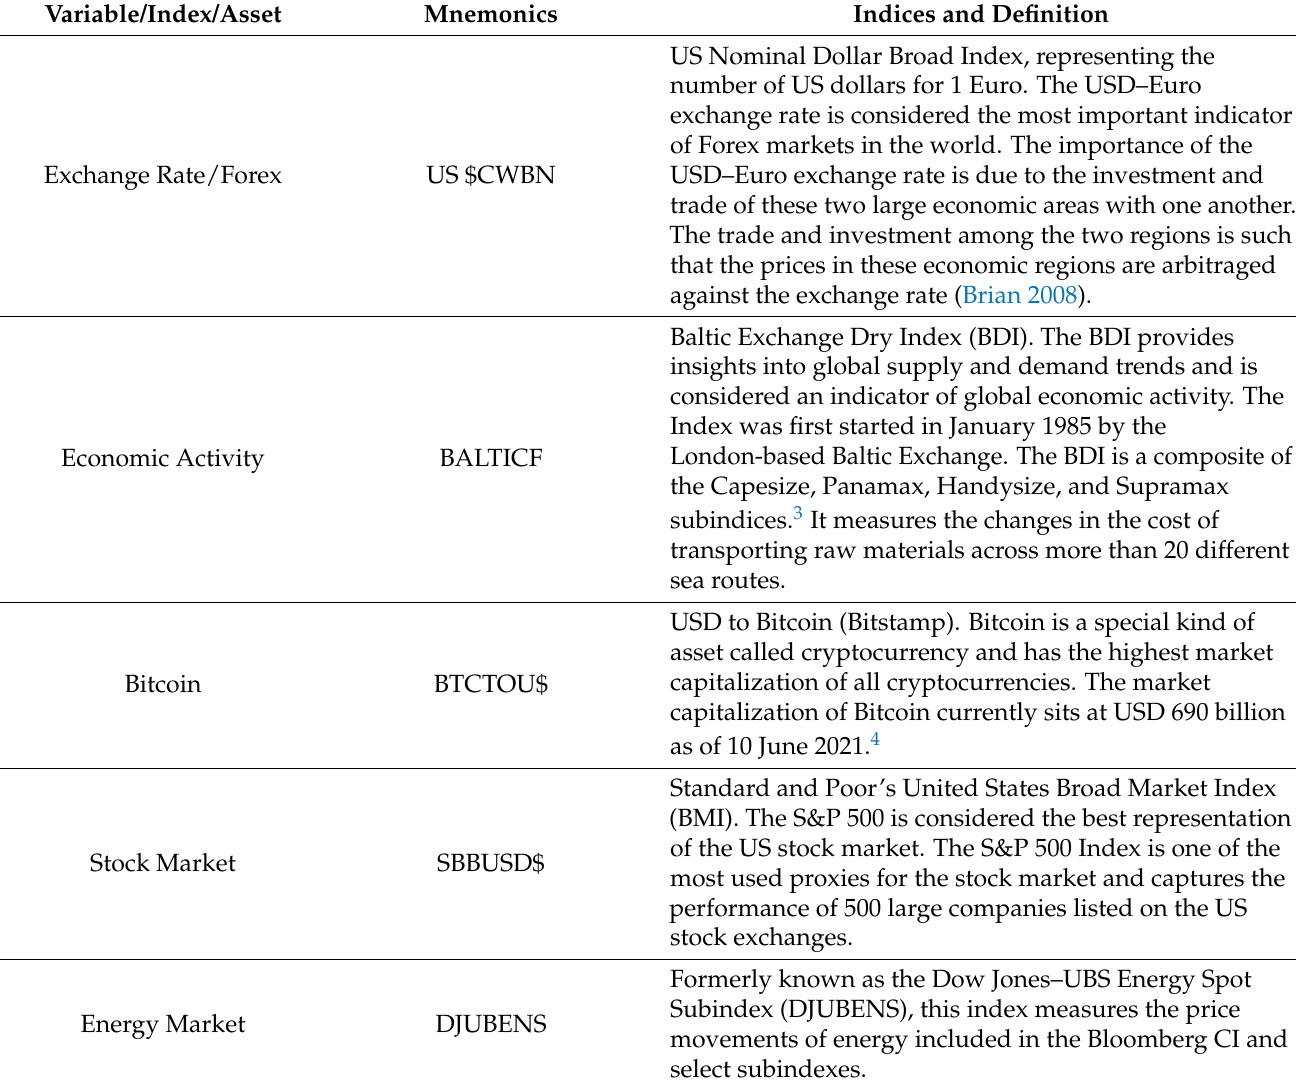
Table 1. Description of